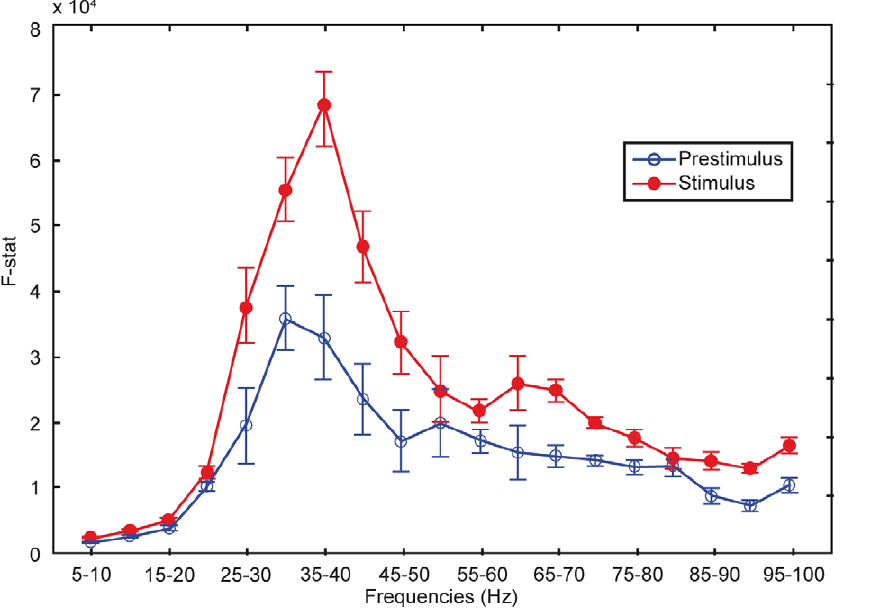
Figure 3. Paralimbic causal information flow during 900 ms prestimulus and 900 ms stimulus conditions vs. 5 Hz frequency bands. Granger causality is seen in both the prestimulus state and during retrieval of self-judgment. Granger causality was maximal in the lower gamma band 30–45 Hz range (bars: standard errors of mean), and larger in the autobiographic memory retrieval condition than in the prestimulus condition (p , 0.0001,